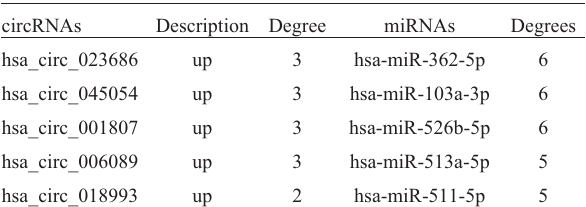
Table 2 - The top 5 DEcircRNAs and miRNAs in miRNA-DEcircRNA network.